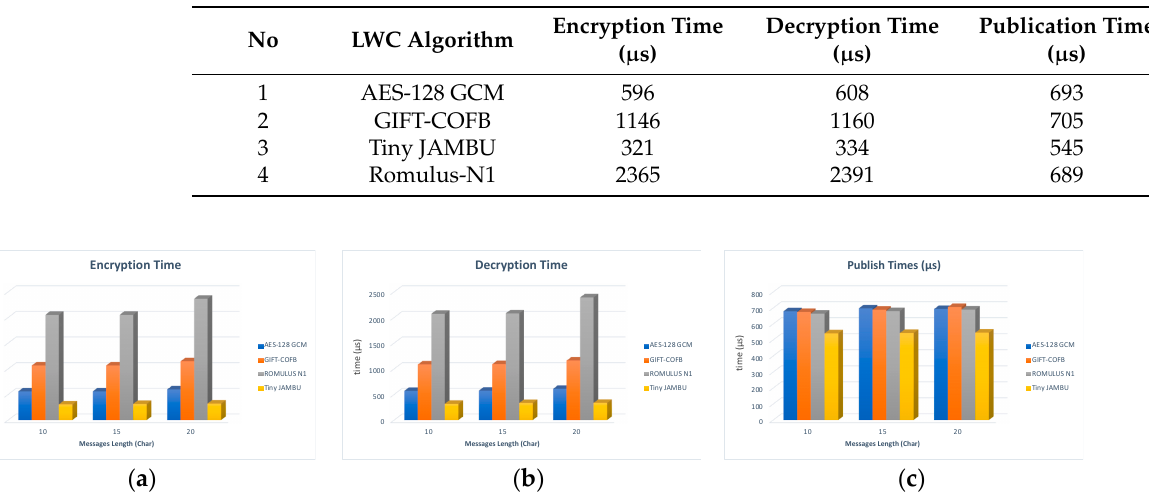
Table 7. Lightweight Cryptographic Encryption and Decryption Performance on NodeMCU with 15 Characters Messages used Registered Account.